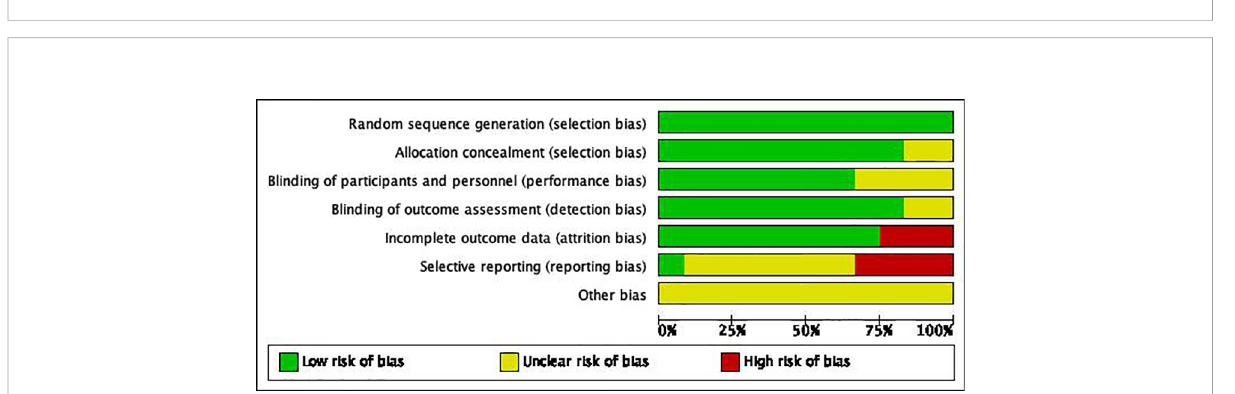
FIGURE 2 Selection process of included literature.